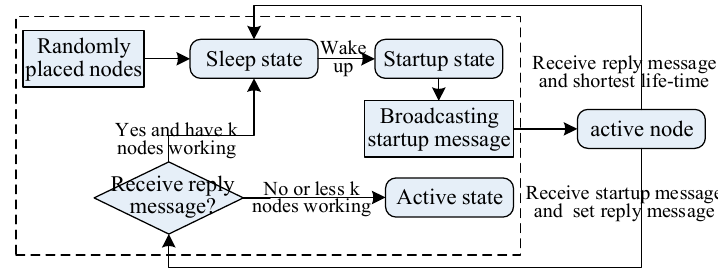
Figure 3. Network deployment processes and topology generation method.